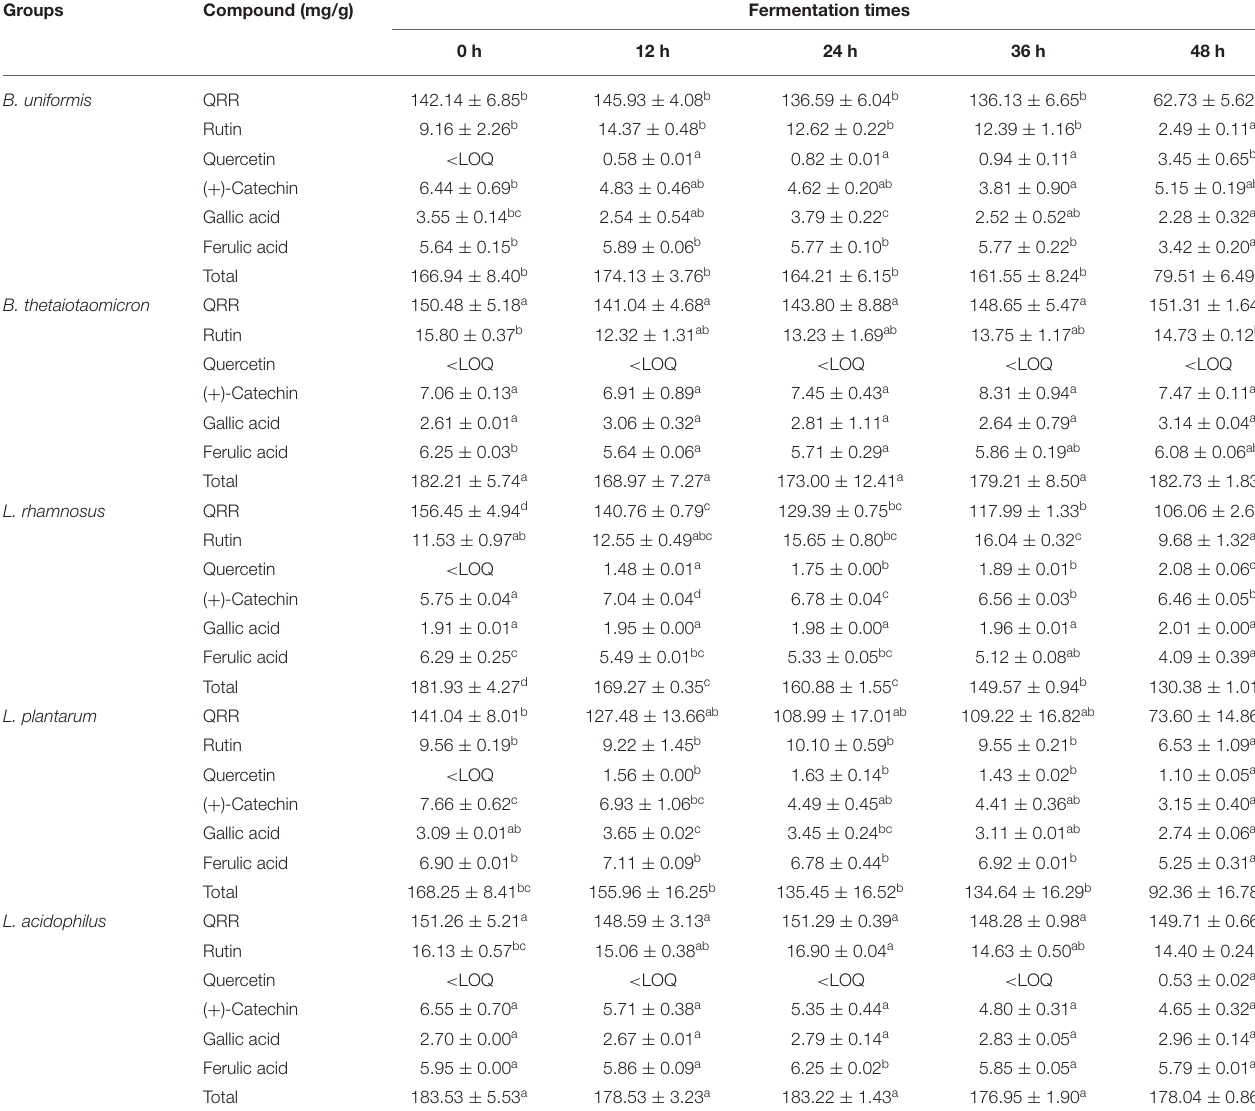
TABLE 1 | Phenolic contents of the supernatants of five microbial cultures during fermentation a .